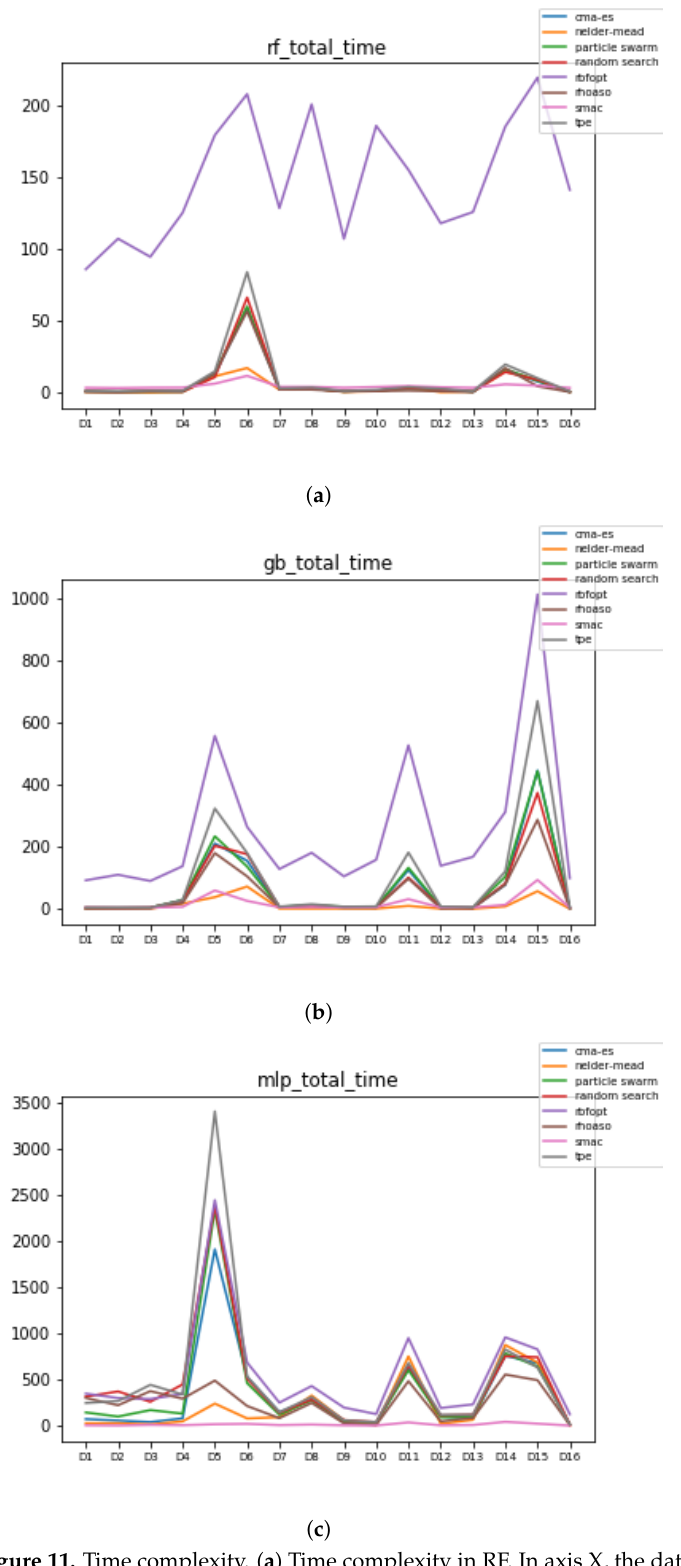
Figure 11. Time complexity. ( a ) Time complexity in RF. In axis X, the dataset. In axis Y, the total time obtained measured in seconds. Each line represents a HPO algorithm. ( b ) Time complexity in GB. In axis X, the dataset. In axis Y, the total time obtained measured in seconds. Each line represents a HPO algorithm. ( c ) Time complexity in MLP. In axis X, the dataset. In axis Y, the total time obtained measured in seconds. Each line represents a HPO